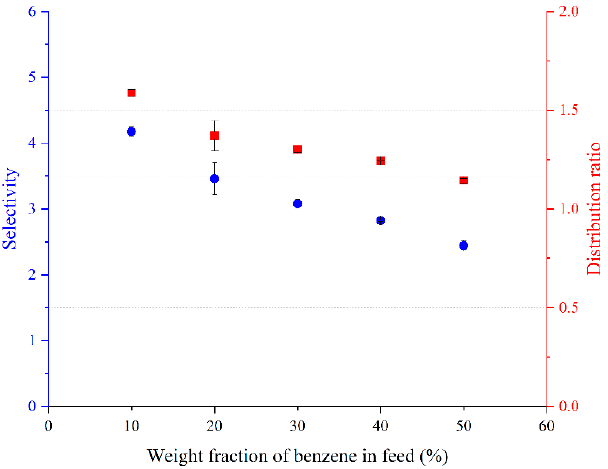
Figure 5. Variation of the distribution ratio and selectivity with benzene weight fraction in the feed for [Benzene (1) + Cyclohexane (2) + BTBACl:Ph (1:2) (3)].